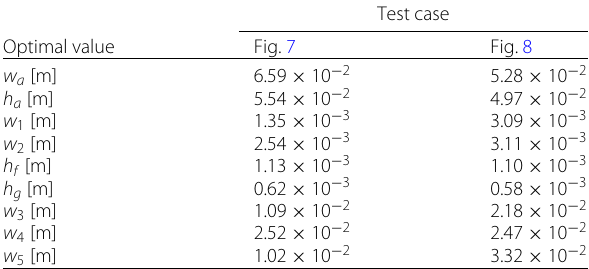
Table 4 SbD validation. Optimized geometrical